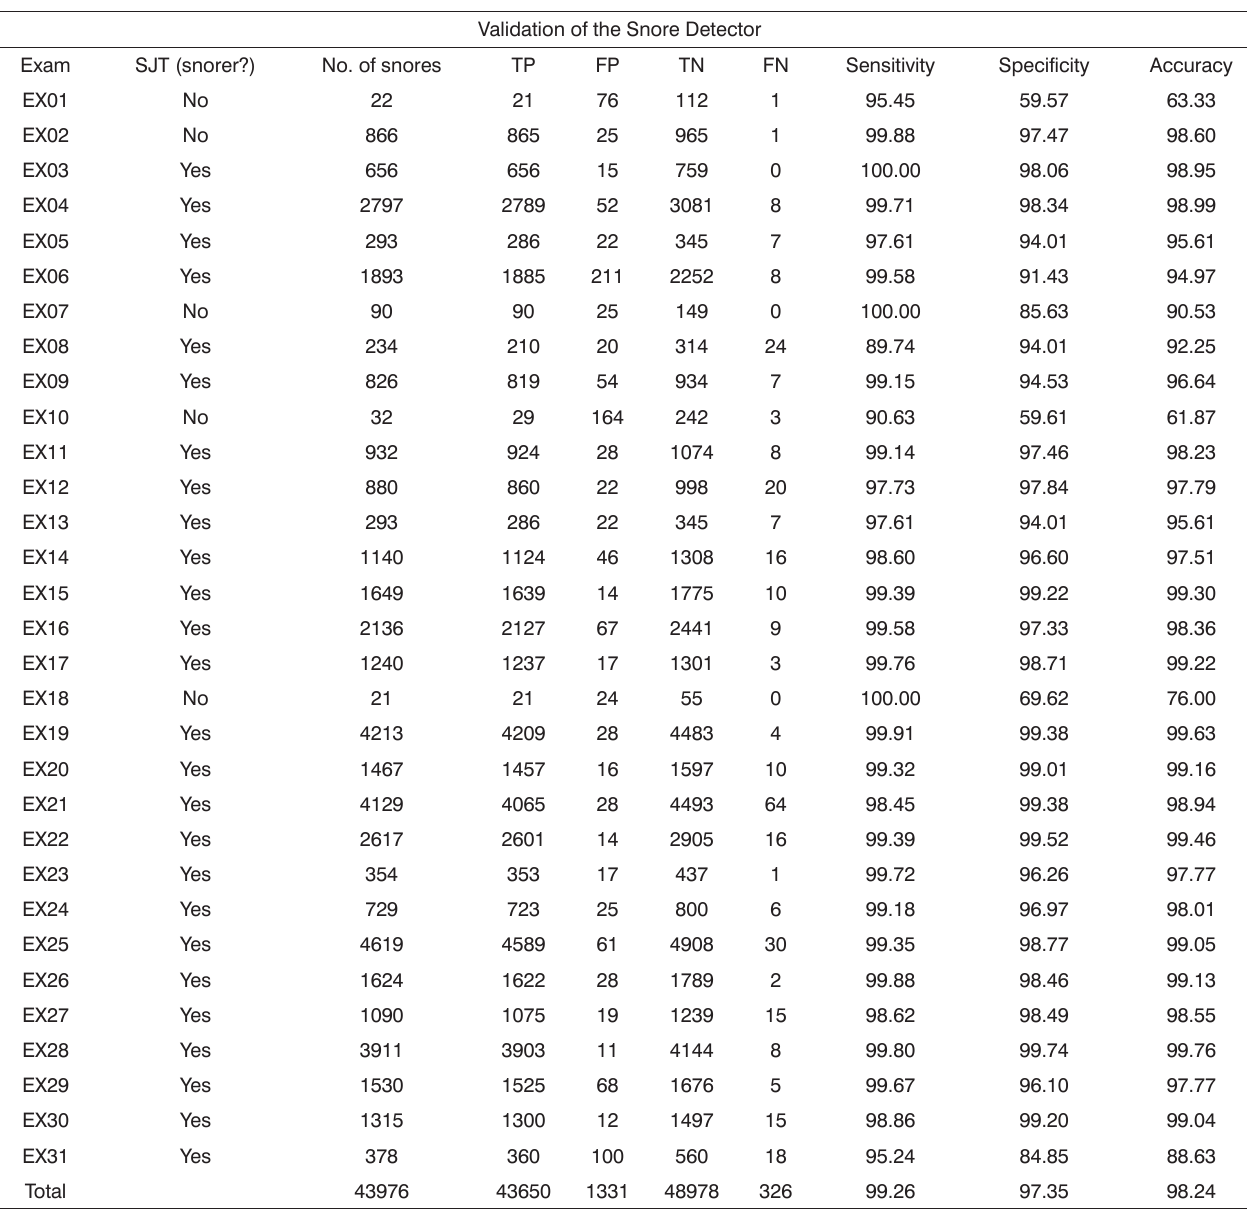
Validation of the Snore